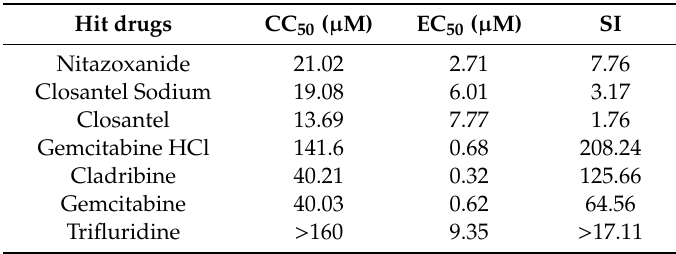
Figure 3. The antiviral effects of the identified drugs were analyzed by quantification of viral DNAs. F81 cells seeded in 6-well plates were pretreated with 5 μ M, 10 μ M, or 20 μ M of Nitazoxanide ( A ), Closantel Sodium ( B ), or Closantel ( C ) before CPV infection. Total DNA was extracted at 40 hpi from